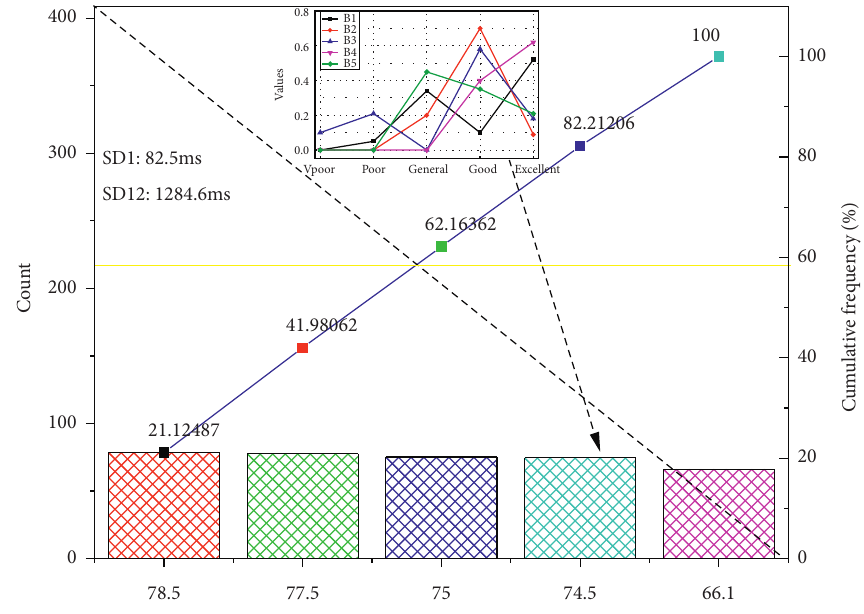
Figure 8: Average processing time.